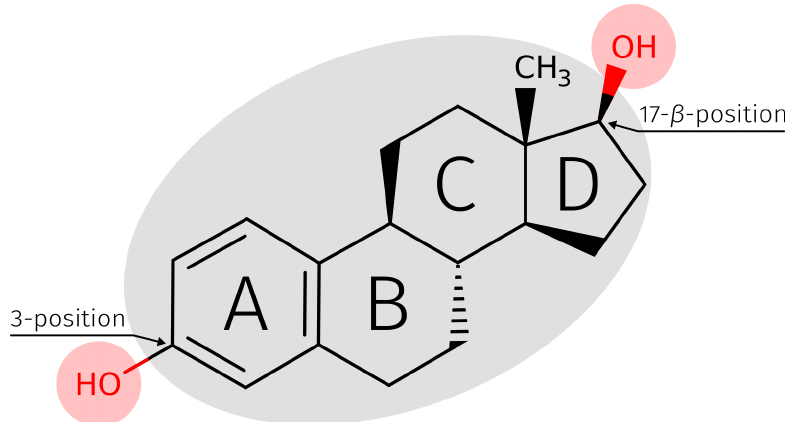
Figure 1. Skeletal formula of E2 with three highlighted structural features. The two red shaded circles are hydroxyl groups at 3- and 17- β -position and can act as donor or acceptor in H-bonds. The grey shaded area represents the hydrophobic rigid backbone. The A-ring of E2 is the aromatic ring system for the formation of possible π -stacking interactions. Skeletal formula of E2 adapted from DrugBank [39]. E2, 17 β